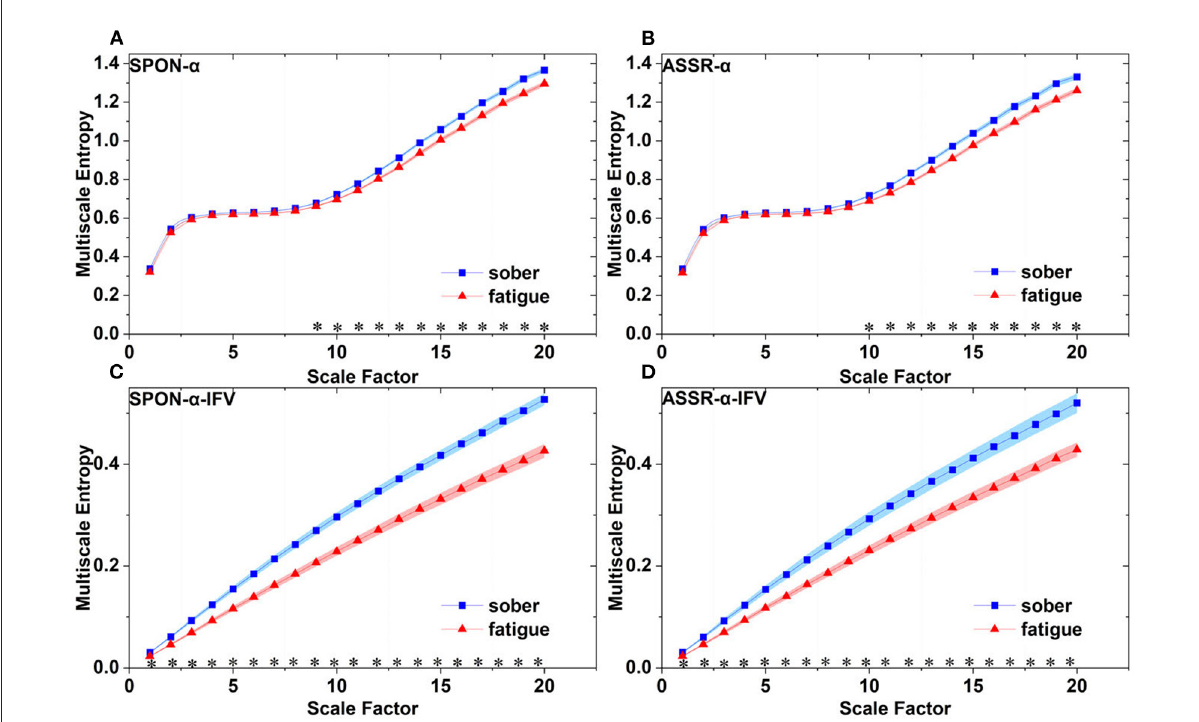
FIGURE9 Comparison of MSE from occipital lobe (channel O1) on: (A) alpha rhythm from spontaneous EEG (SPON- α ), (B) alpha rhythm from ASSR (ASSR- α ), (C) IFV in alpha rhythm from spontaneous EEG (SPON- α -IFV), and (D) IFV in alpha rhythm from ASSR (ASSR- α -IFV). The sign * indicates significance at p < 0.05. Shades indicate the standard errors.